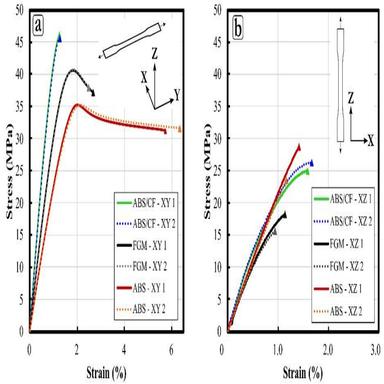
Stress and strain graph of ABS, CF/ABS and FGM composites fabricated on XY and XZ plane.